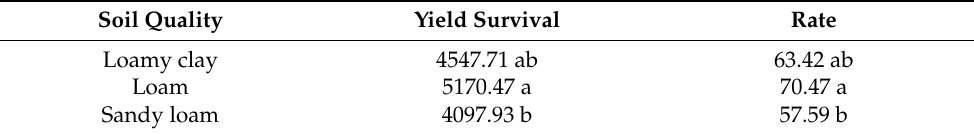
Table 3. Significance analysis of yield and survival rate in the experimental area.